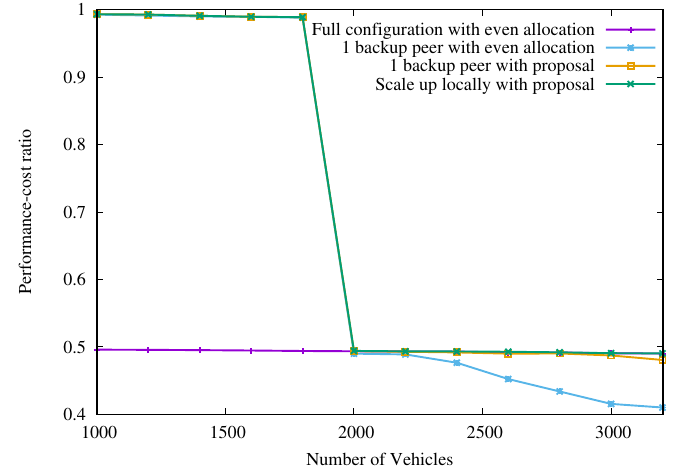
Figure 16. Performance-cost ratio of the system success ratio.